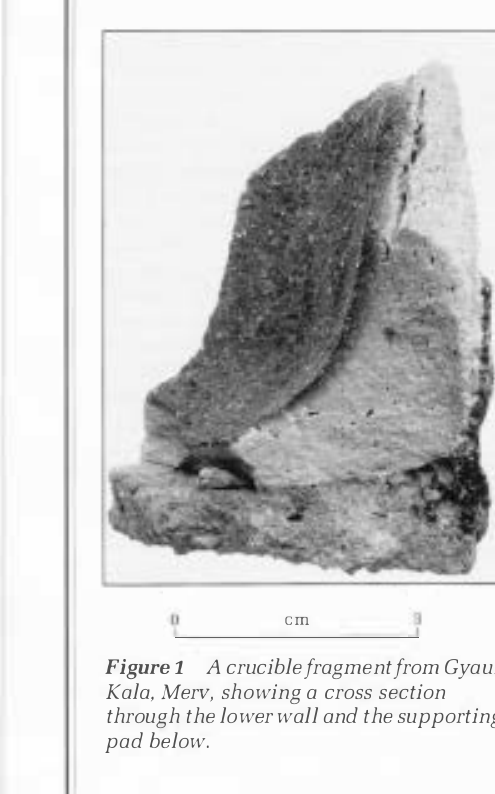
A crucible fragment from Gyaur Kala, Merv, showing a cross section through the lower wall and the supporting pad